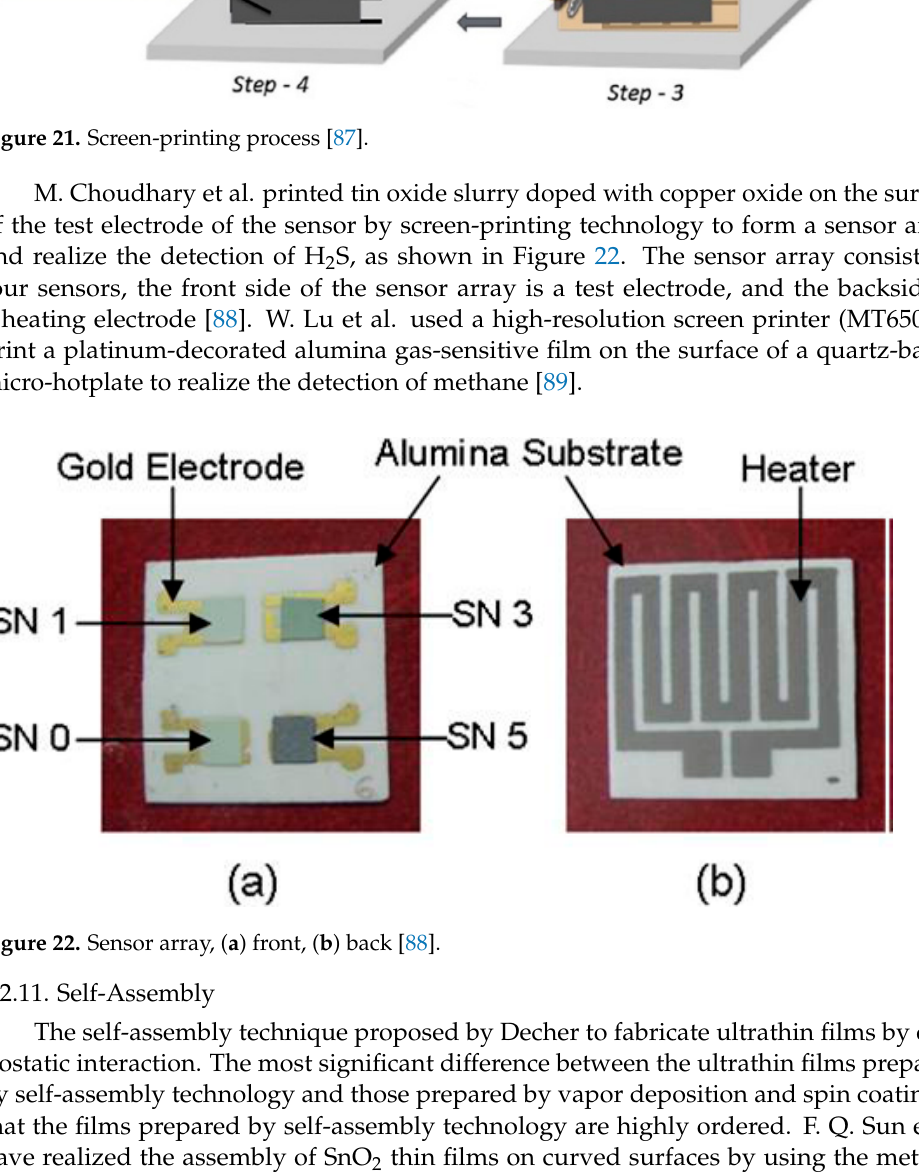
Figure 23. ( i ) Glass plate covered with PS colloid immersed in the solution. ( ii ) Monolayer of colloid floating on the surface of the solution. ( iii ) Pick up with glass rod. ( iv ) Drying. ( v ) Calcination to remove the PS microspheres [90].